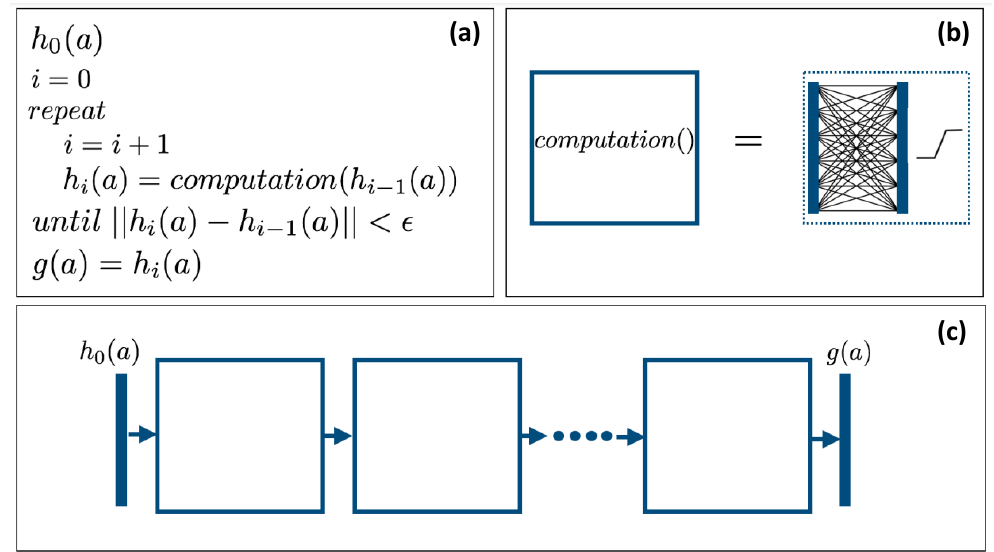
Figure 2. In panel ( a ), pseudo code representing the CLHE algorithm. In panel ( b ), the computation function can be represented as a single layer neural net block. In panel ( c ), by replicating the computational block enough times, we can calculate CLHE using a neural